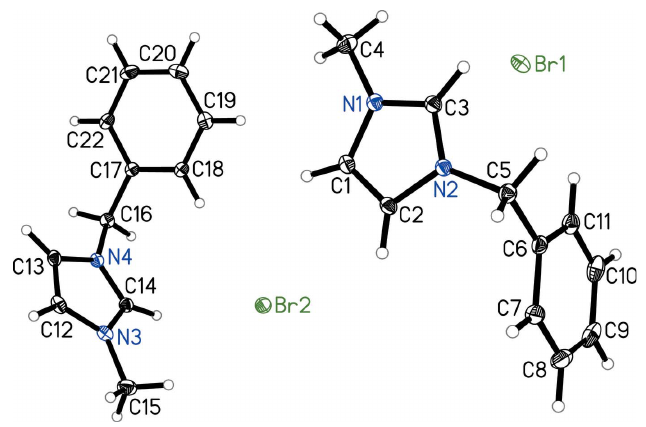
Figure 1 Molecular structure of the title compound. Displacement ellipsoids correspond to 30%